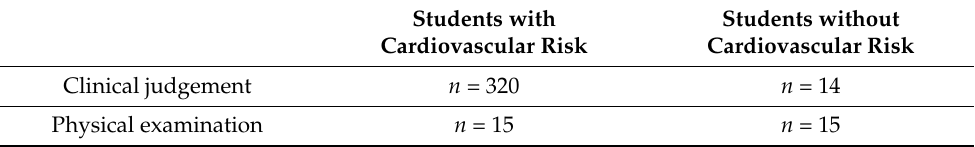
Table 2. Cardiovascular risk